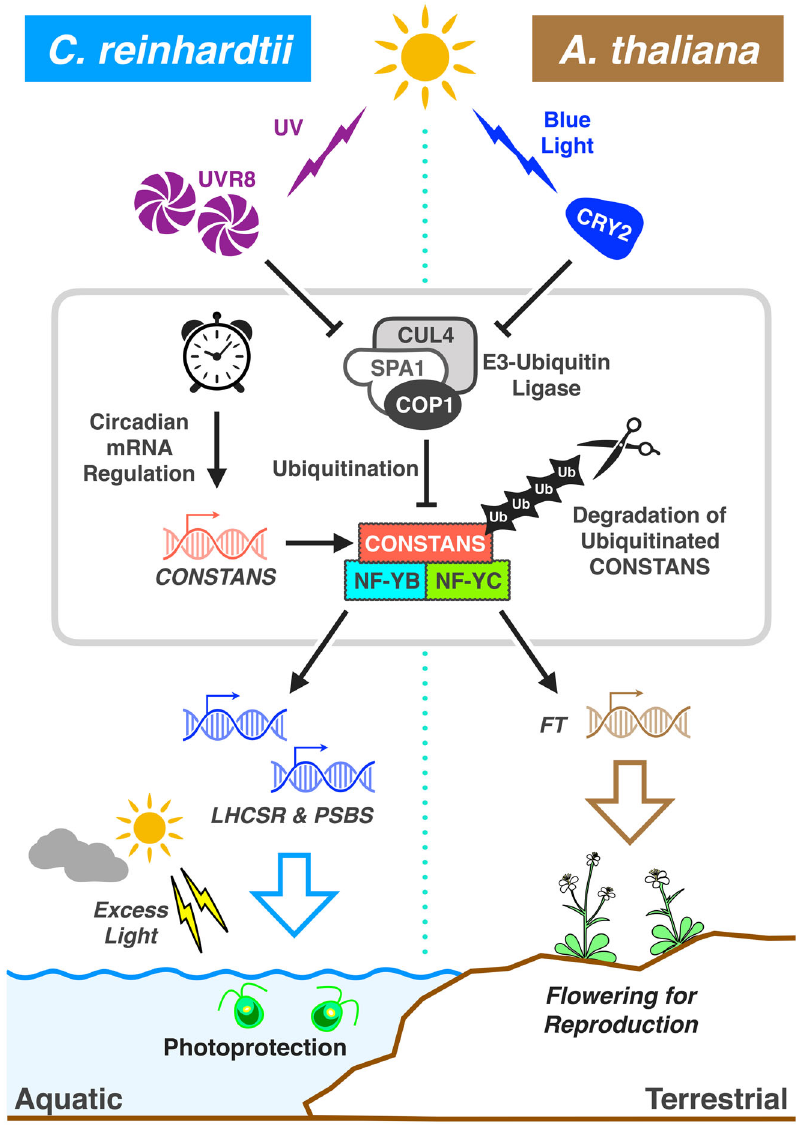
Fig. 4 Hypothetical signal transduction pathways and physiological functions of CONSTANS/NF-YB/NF-YC-dependent control of the target genes in C. reinhardtii and A. thaliana . Blue light perception by the photoreceptor CRY2 in A. thaliana deactivates the E3 ubiquitin ligase module 27,28 , whereas UV light perception via conversion of the dimeric form of UVR8 to the monomeric form deactivates this module in C. reinhardtii 7 . Circadian clock-regulated CONSTANS transcripts 10 are translated, and successfully accumulate in the organisms when proteasome- and ubiquitin-dependent degradation is inactivated. The CONSTANS/NF-YB/NF-YC transcriptional module then transcribes FT 10 and photoprotective genes (e.g., LHCSR1 , LHCSR3 , and PSBS )